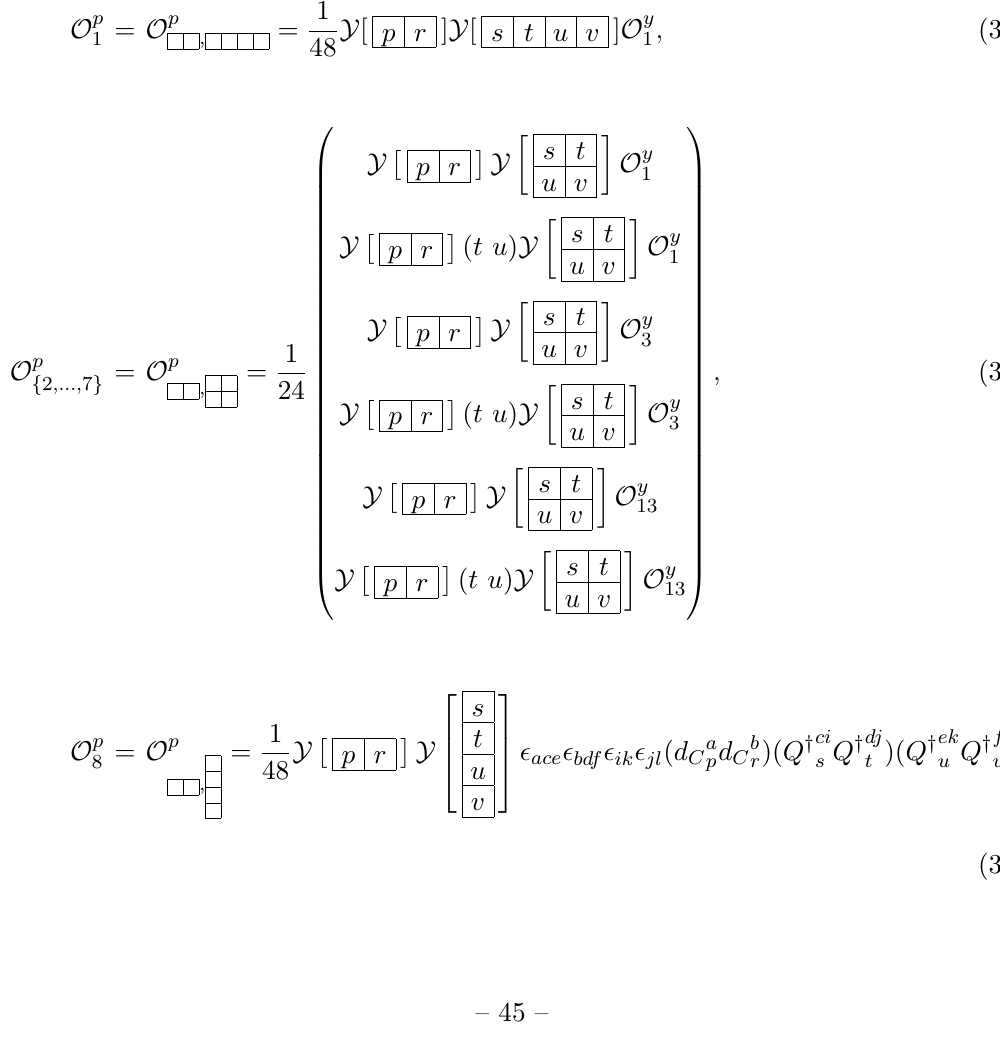
symmetry group. Here we index the p-basis operators and label the permutation symme- tries of the repeated fields of d and Q † in terms of Young diagram in the subscripts: C = O p O p 1